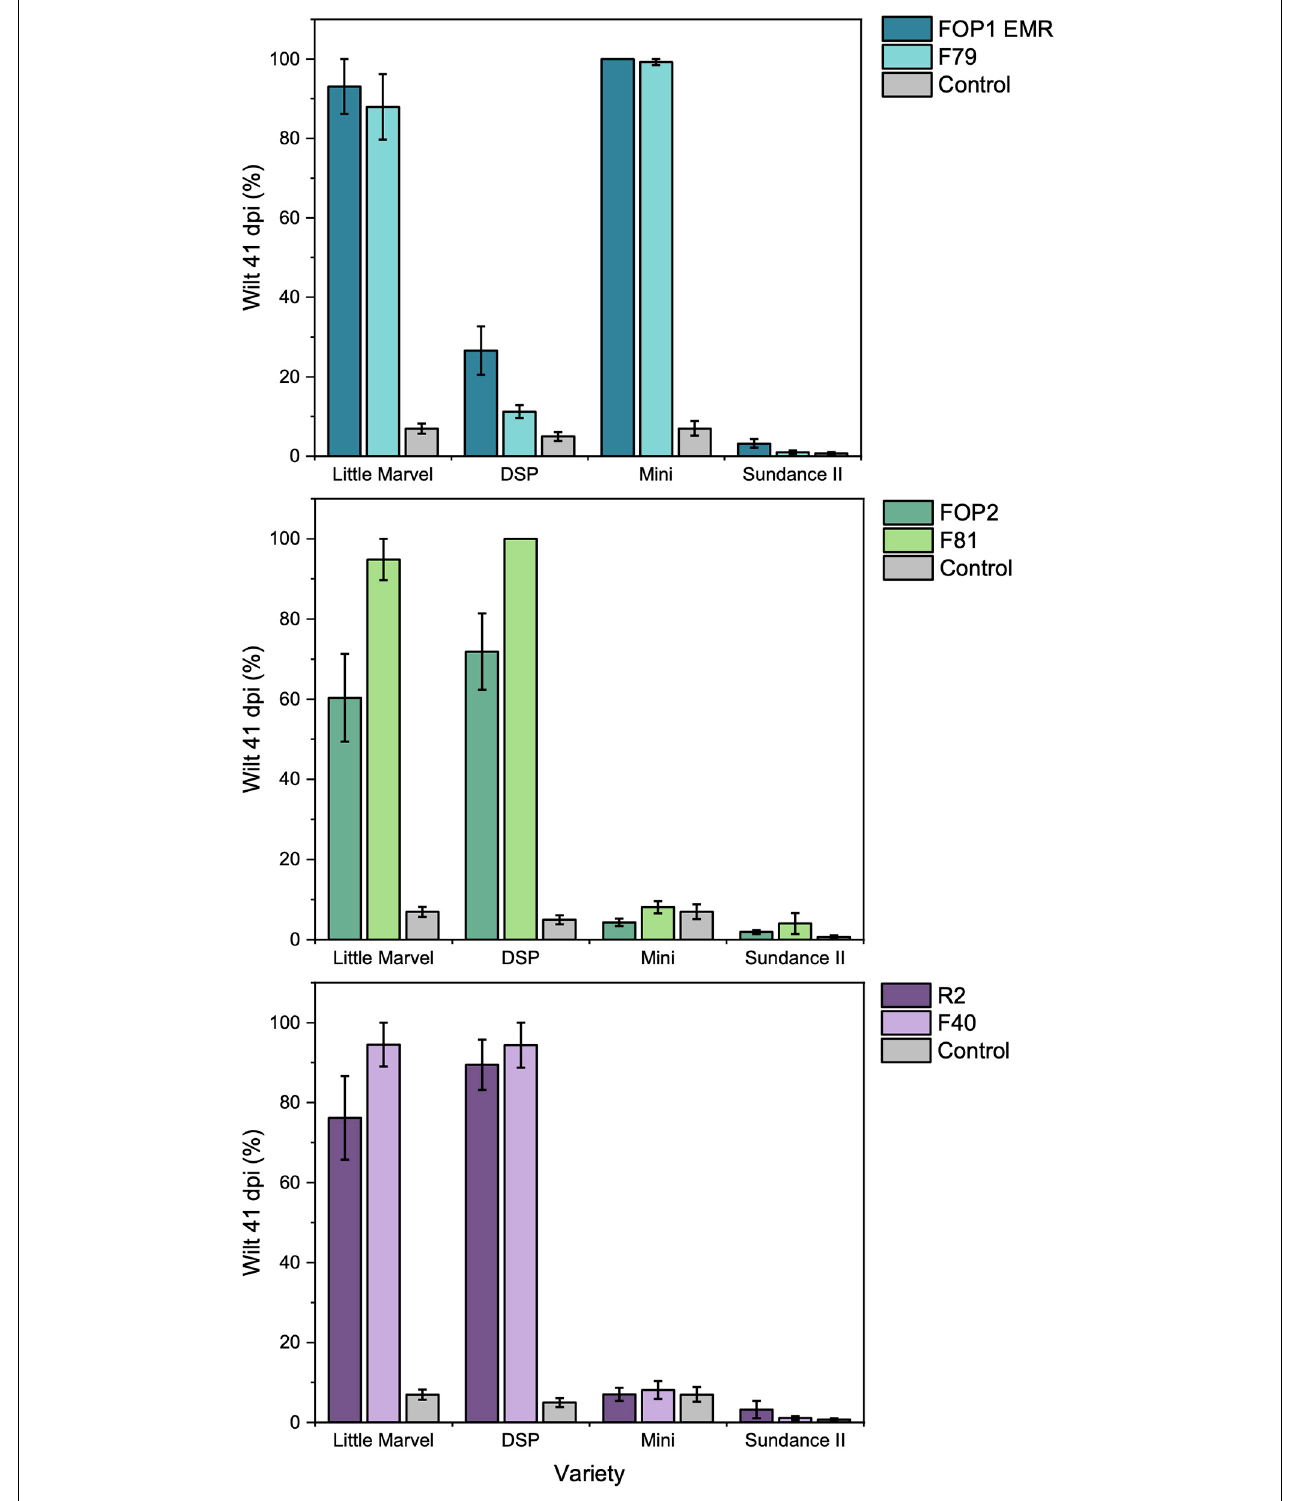
FIGURE 3 | Pathogenicity of SIX FOP isolates on four differential cultivars of pea (Little Marvel, DSP, Mini, and Sundance II) using the root dip inoculation method. Top = putative race 1 isolates; middle = putative race 2 isolates and bottom = putative race 2 S isolates. Values are average percentage wilt of 14 inoculated plants, error bars are